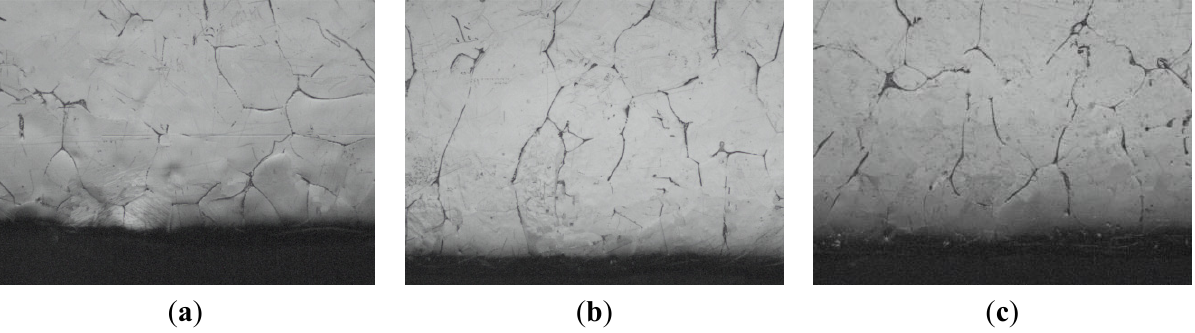
Figure 12. Macrostructures at the bottom of commercial pure aluminum refined with three types of Al–5Ti master alloys (holding for 120 min): ( a ) 1.0 wt% master alloy 1 #